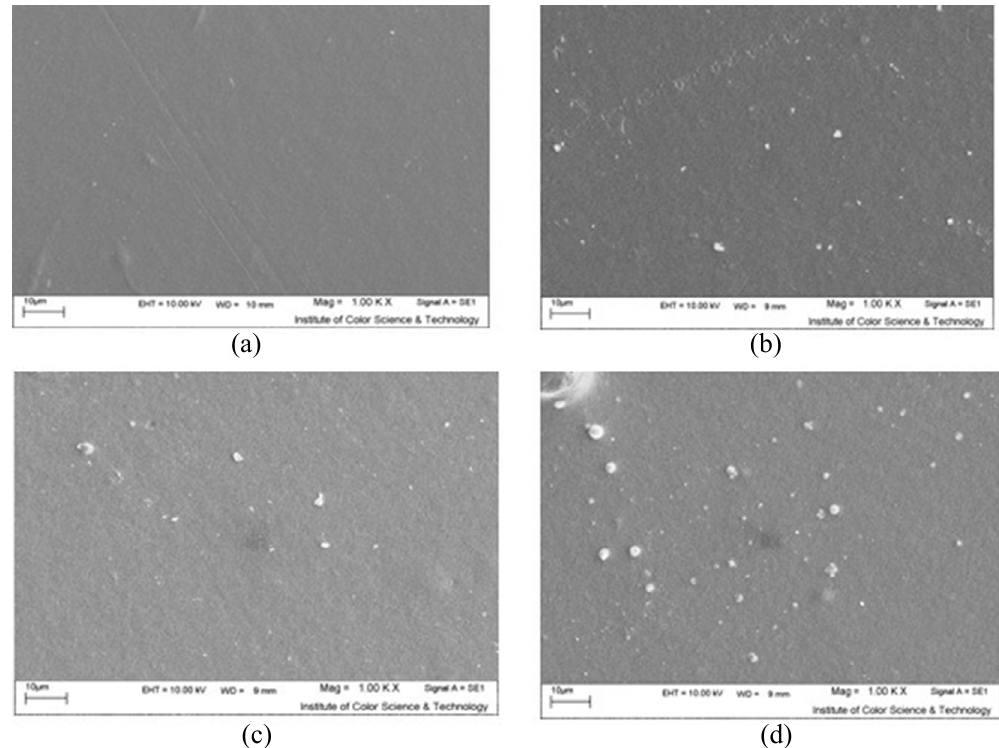
Fig. 1. SEM of LDPE film without any NPL (a), LDPE film loaded by 1% ZnO NPLs (b), LDPE film loaded by 1% TiO 2 NPLs (c), LDPE film loaded by 1% mixed of TiO 2 and ZnO NPLs